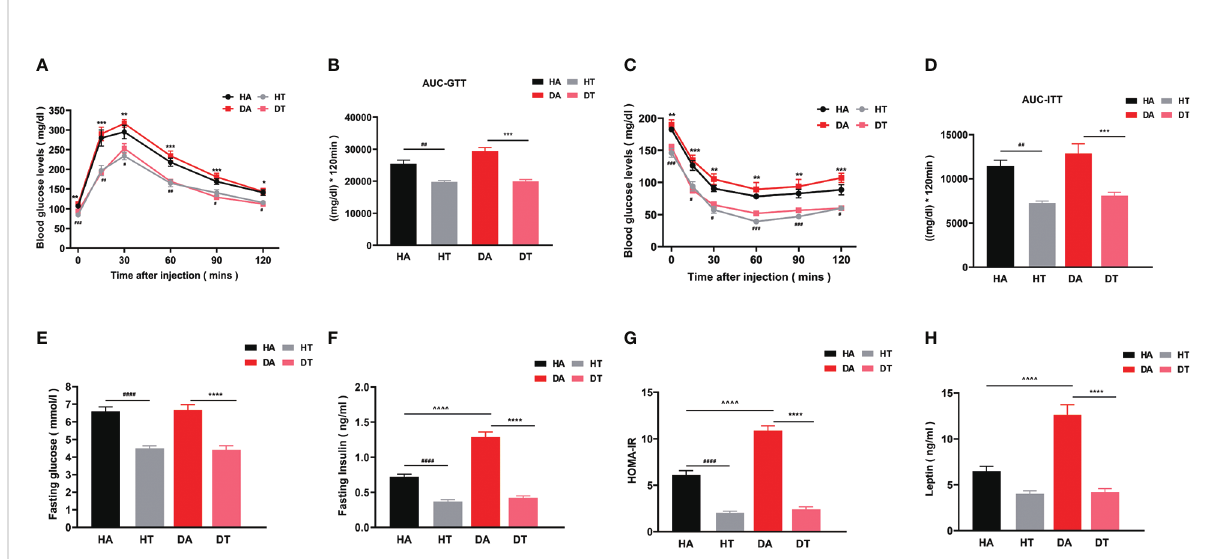
FIGURE 3 TRF improves glucose intolerance and reverses insulin resistance in mice with polycystic ovarian syndrome (PCOS). (A, B) Oral glucose tolerance test (OGTT, glucose 2 g/kg), (C, D) Insulin tolerance test (ITT, insulin 0.5 U/kg), (E) Plasma fasting glucose level in four groups. (F) Plasma fasting insulin level in four groups. (G) Homeostatic Model Assessment for Insulin Resistance (HOMA-IR), (H) Plasma leptin level. All data were presented as mean ± SEM **P < 0.01, ***P < 0.001, ****P < 0.0001, DA group vs. DT group; # P < 0.05, ## P< 0.01, ### P < 0.001, #### P < 0.0001, HA group vs. HT group, ^^^^P < 0.0001, DA group vs. HA